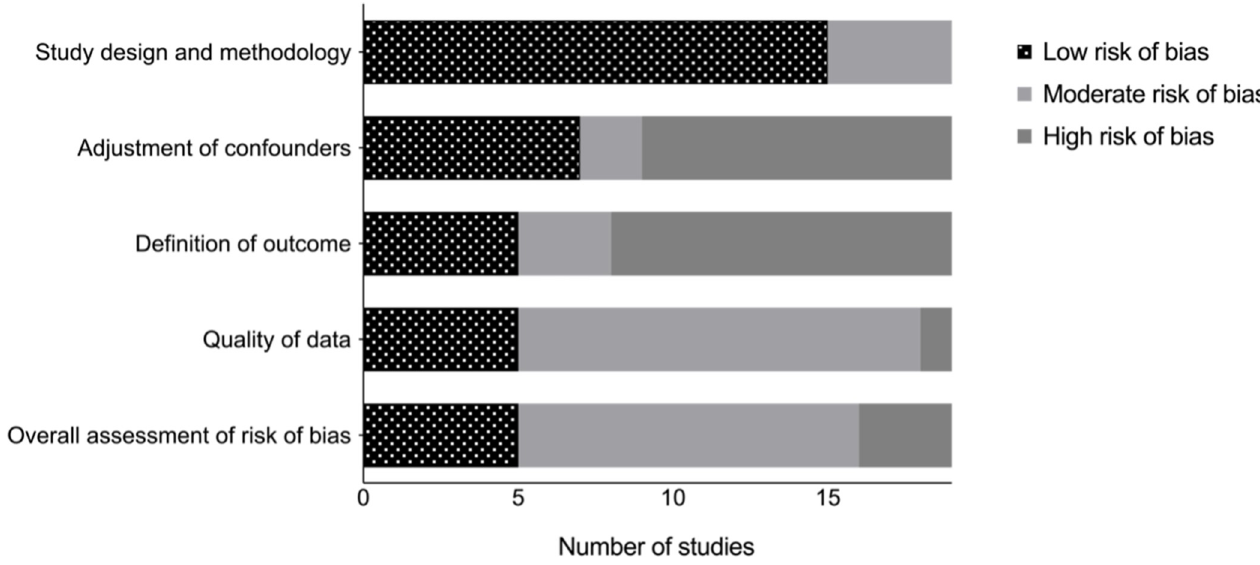
Fig 2. Quality assessment for the risk of bias in the 19 included studies for